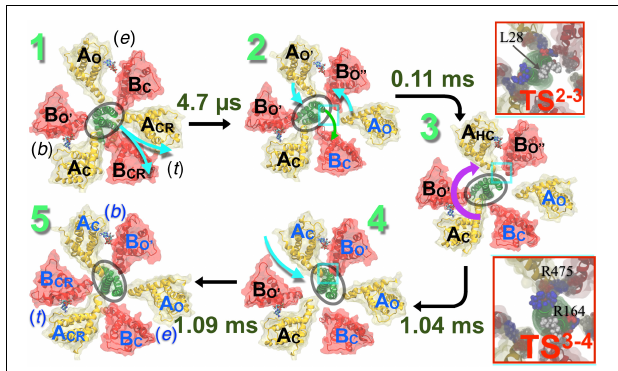
FIGURE 6 | Conformational transitions mechanism of V 1 proposed by computer simulation studies. Pathway of the hydrolysis-driven conformational transition in the entire V 1 domain derived from the string method with swarms of trajectories (Pan et al., 2008). Firstly, the transition from a ‘tight’ (t) to an ‘empty’ (e) conformation (1 → 2) is observed at the ADP+Pi-bound site, where A CR B CR is transformed to A O B C . This transition promotes ATP binding at the neighboring ‘empty’-site. This empty site transforms from the A O B C conformation in state 1 to a bindable A O (cid:48) B O (cid:48)(cid:48) form in state 2. ATP-binding to the bindable site yields the first doubly bound state (2 → 3); the ATP binding simultaneously induces a local deformation of the DF-shaft. The shaft then rotates yielding the second doubly bound state (3 → 4). Finally, a bound ATP (b) in the third site, in A C B O (cid:48) form, transitions to the reaction mode in the ‘tight’ (t) conformation, promoting subsequent hydrolysis (4 → 5). Rates of each of these transitions are computed employing techniques described in Singharoy and Chipot (2017) and Singharoy et al. (2017) and labeled along with each step. The rotation step is found to be the slowest when it follows product release. (Upper inset) The 2 → 3 transition necessitates a wring deformation of the shaft that marginally exposes the hydrophobic residue L28 to water. This unfavorable solvation characterizes the first TS (TS 23 ). (Lower inset) Salt bridges between residues of the shaft and those of the A HC and B O (cid:48)(cid:48) subunits reorganize during the shaft-rotation step, involving transient repulsive electrostatic interactions of residues R164 (DF) with R475 (A HC